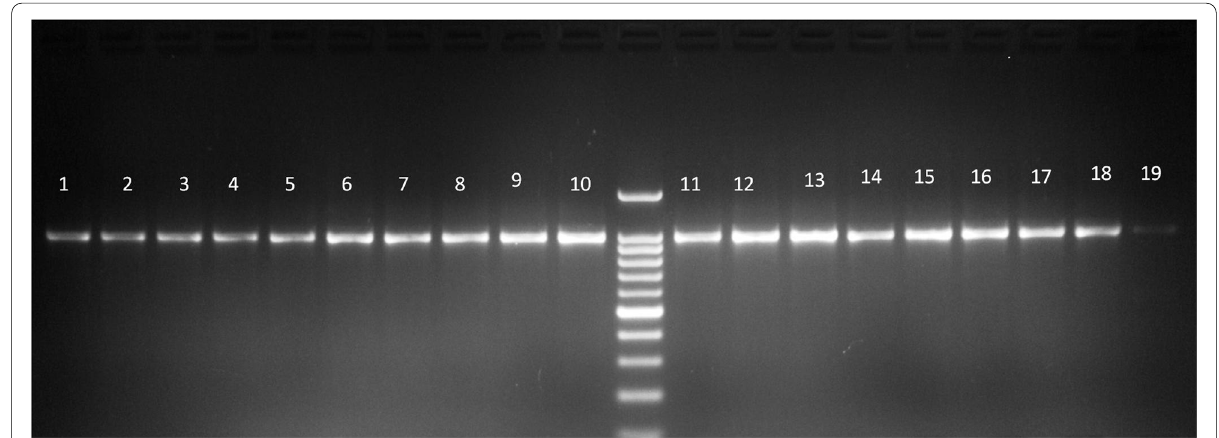
Fig. 1 Gel electrophoresis showed band formation at 831